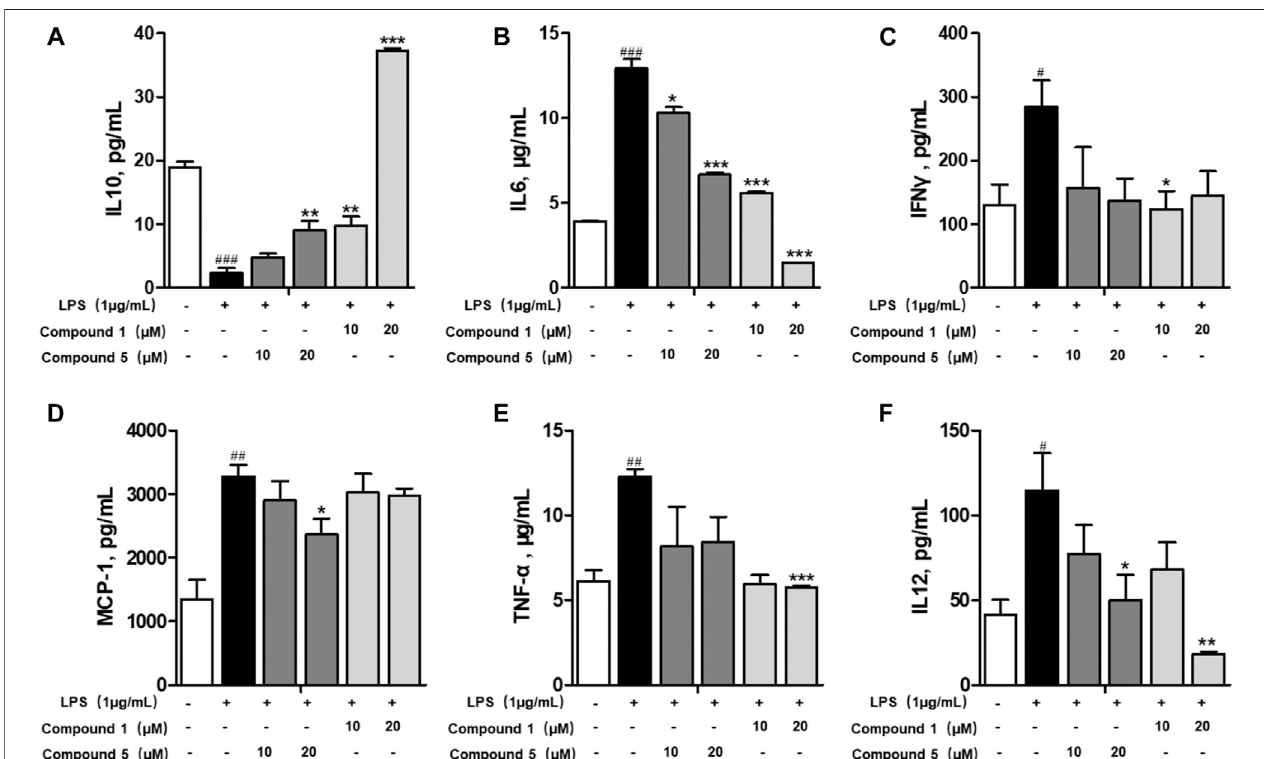
FIGURE 7 | Effects of 1 and 5 on the production of cytokines by LPS-induced RAW264.7 cells. The level of IL10 (A) , IL6 (B) , IFN γ (C) , MCP-1 (D) , TNF- α (E) , and IL12 (F) producedbyLPS-stimulatedRAW264.7cellstreatedwith 1 or 5 .Datawerepresentedasthemean ± SEM( n (cid:2) 3). # p < 0.05, ## p < 0.01, ### p < 0.001vs.control, * p < 0.05, ** p < 0.01, *** p < 0.001 vs.